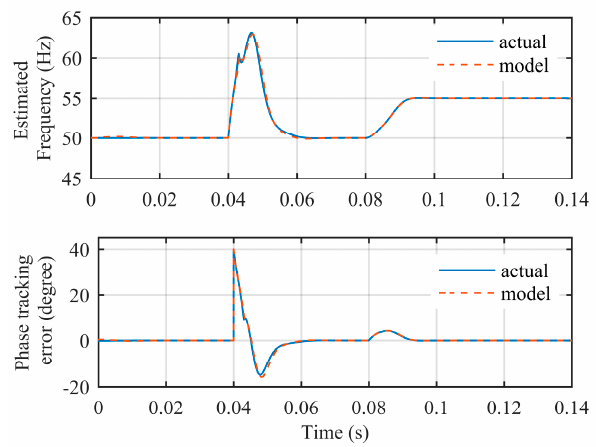
Figure 17. Dynamic behavior of the actual proposed PLL and its model.